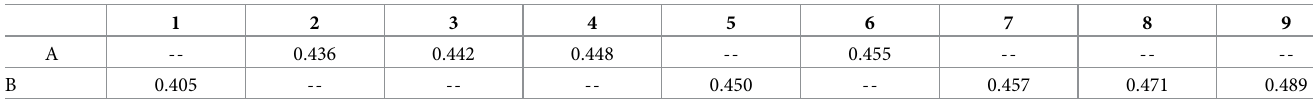
2. A mono-factor separation test between black fungus and the sticks was designed, and the interference of the loading speed on the static separation force test was eliminated by the separation test of loading speed. Under quasi-static conditions, the separation force between black fungus and the fungus stick in the picking season was determined to be between 1.06N and 3.65N. When the tension angle was 0˚, the average separation force was 3.167N. Through variance